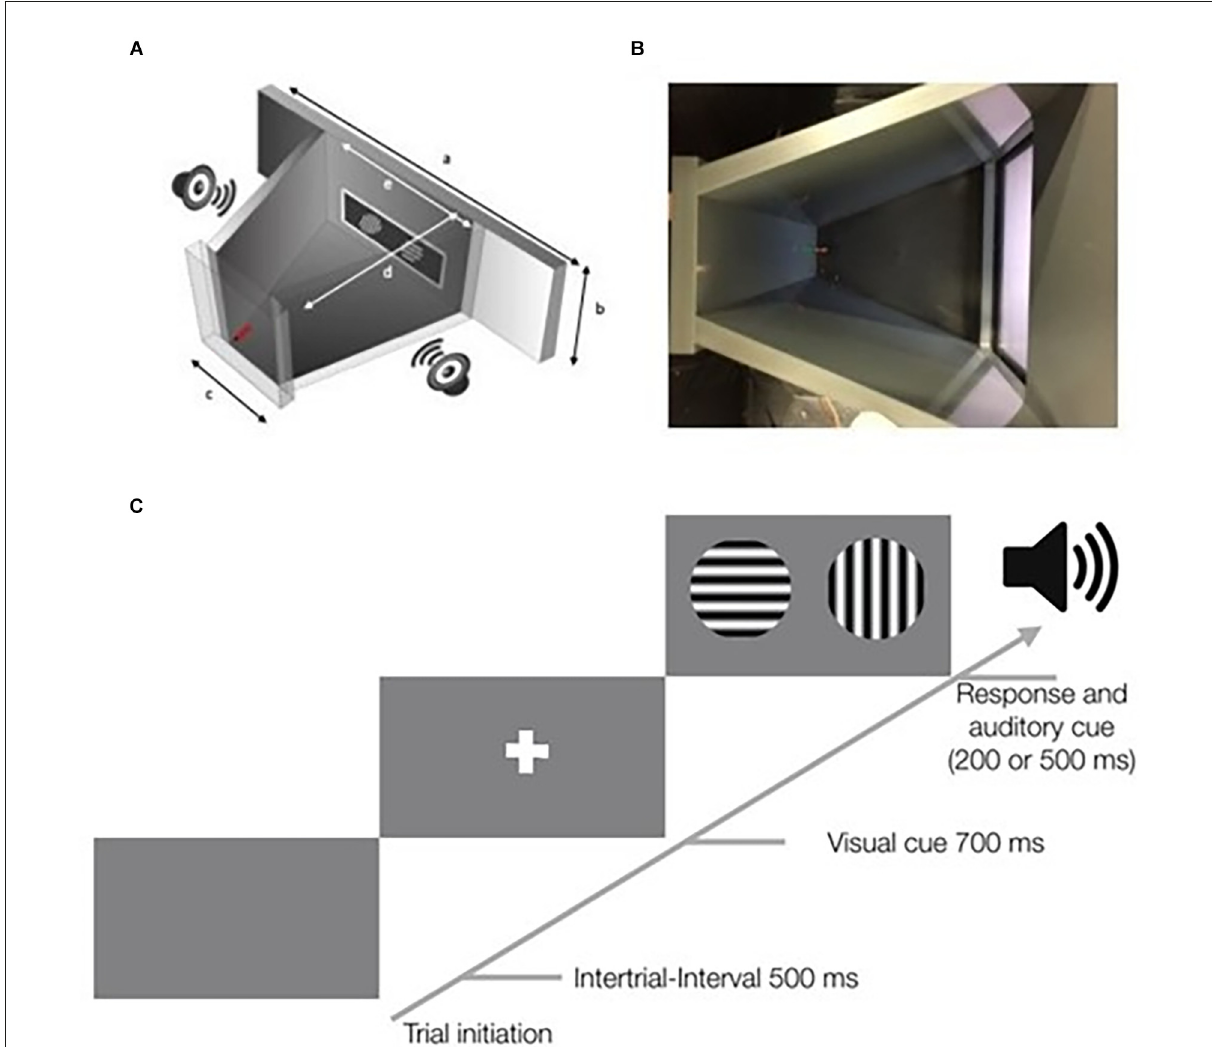
FIGURE1 Schematic overview of the touchscreen chamber and a schematic of the stimulus protocol. (A) Overview of the touchscreen chamber. A screen with a touchscreen frame was placed in a drilled hole. The screenholder has dimensions of 410 mm × 273 mm (a). The dimension within the training area of the screenholder is 165 mm × 273 mm (e). Outside of the closed training area (gray) two loudspeakers were placed on each side. On the opposite wall [47 mm × 273 mm (c)] to the screen, a red water spout was placed below a green LED light. The distance between is 160 mm (d). Further information on the dimensions of the setup, including a 3D-model, is available in the online repository. (B) Top view of the touchscreen chamber. On the right side, the touchscreen is shown. On the left side, the green LED and the red water spout are visible. The viewing angle is similar to that of a webcam that was used to record the mouse in each session. (C) Scheme of a typical trial in the touchscreen chamber. Mice initiate trials by touching the water spout. After a 500-ms delay, a visual cue in form of a white cross is shown for 700 ms. Subsequently, the target and the distractor stimuli are displayed. After the animal responds by touching one of the two stimuli, an auditory cue occurs. A correct response is followed by a short low-pitched tone of 200 ms, while an incorrect response is followed by a longer high-pitched tone of 500